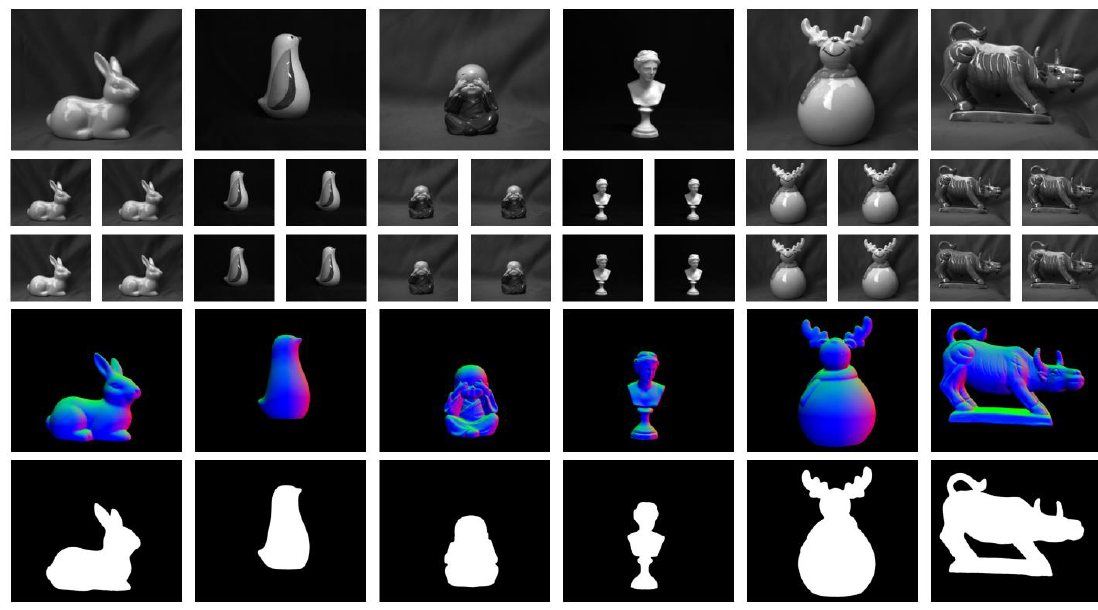
Figure 4 . Six samples of dataset which include polarized images in 4 different degrees (0, 45, 90 and 135) in second row, ground truth in third row and binary mask in fourth row.